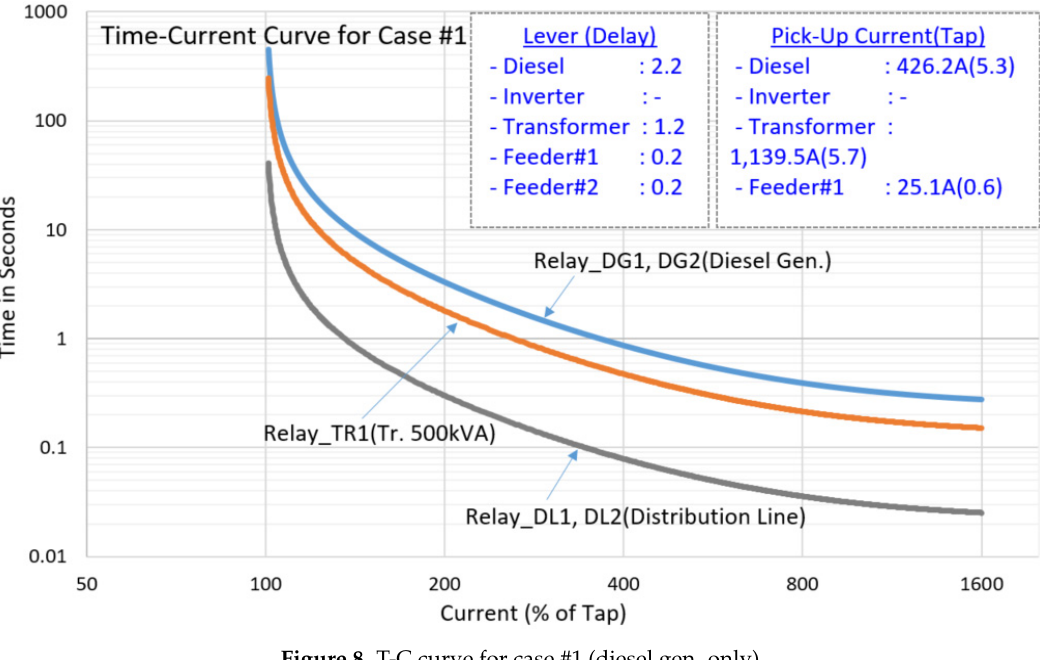
Figure 8. T-C curve for case #1 (diesel gen. only).